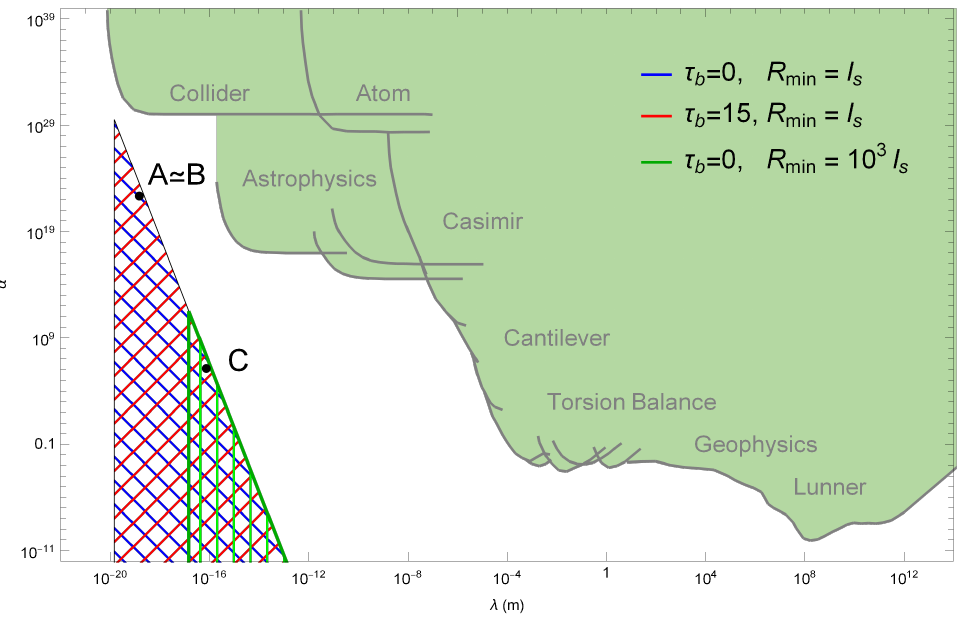
Figure 13 . Allowed regions of parameter space for the unwarped limit τ c → 0 , for different choices of the parameters ( τ b , R min /l s ) and fixed H = 10 − 15 . See main text for further discussion. Figure adapted from [23, 64], with the shaded area indicating the excluded region of parameter space at 95% confidence